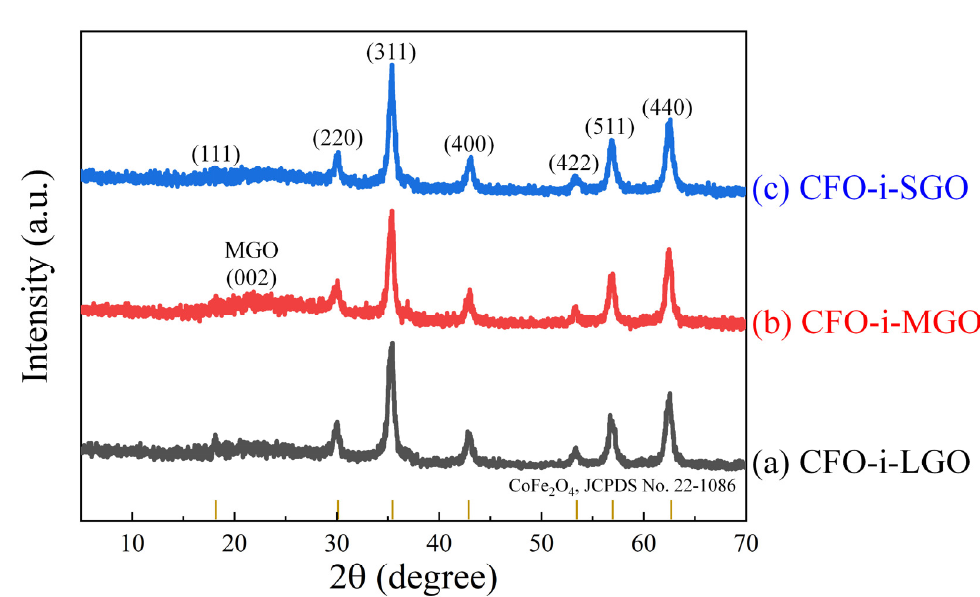
Figure 4. XRD patterns of the two-dimensional (2D) magnetostrictive fillers of ( a ) CFO-i-LGO, ( b ) CFO-i-MGO, and ( c ) CFO-i-SGO.